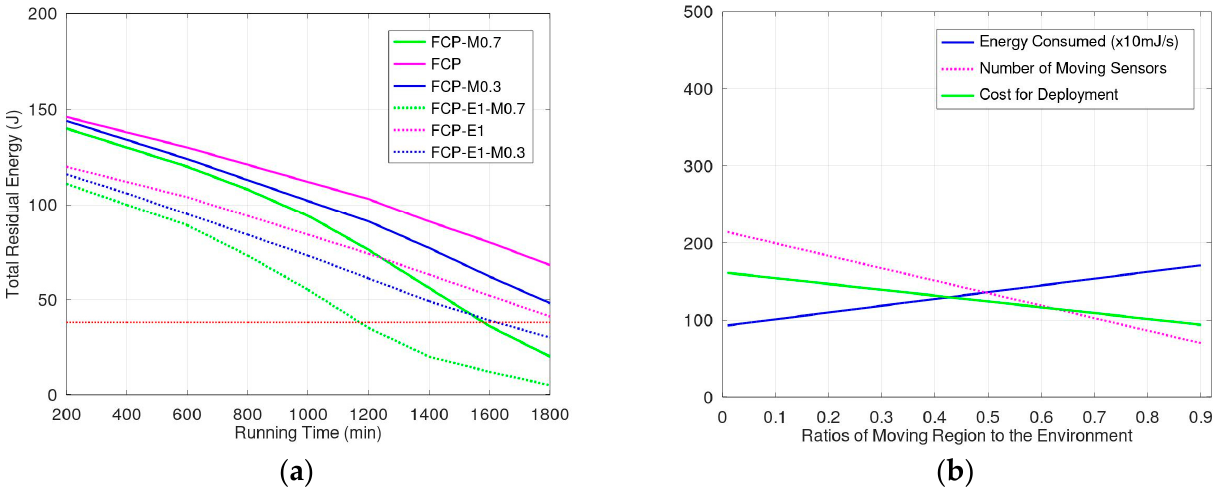
Figure 10. ( a ) Energy evaluations under different energy support condutions and ratios of the movement region to the environment; ( b ) Energy consumed and number of sensors according to the ratio of the movement region to the environment.